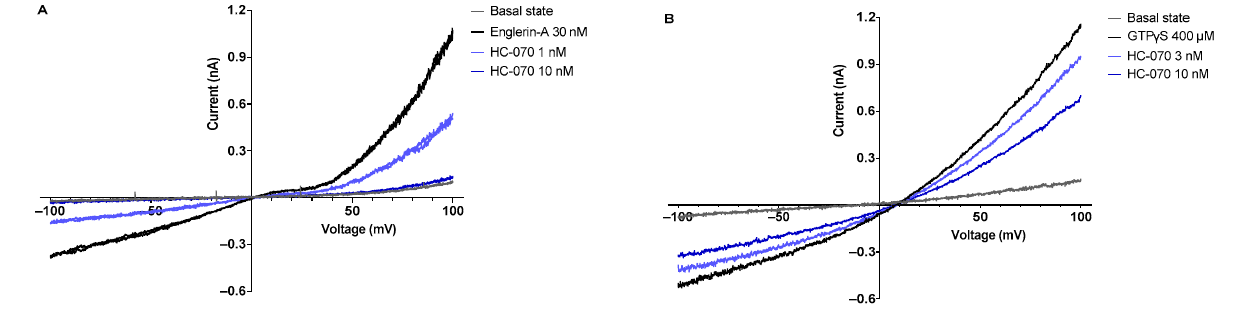
Figure 1. Assessment of primary pharmacology of HC-070 using manual patch-clamp. hTRPC4 current–voltage relationships with activation by Englerin A ( A ) and GTP γ S ( B ).